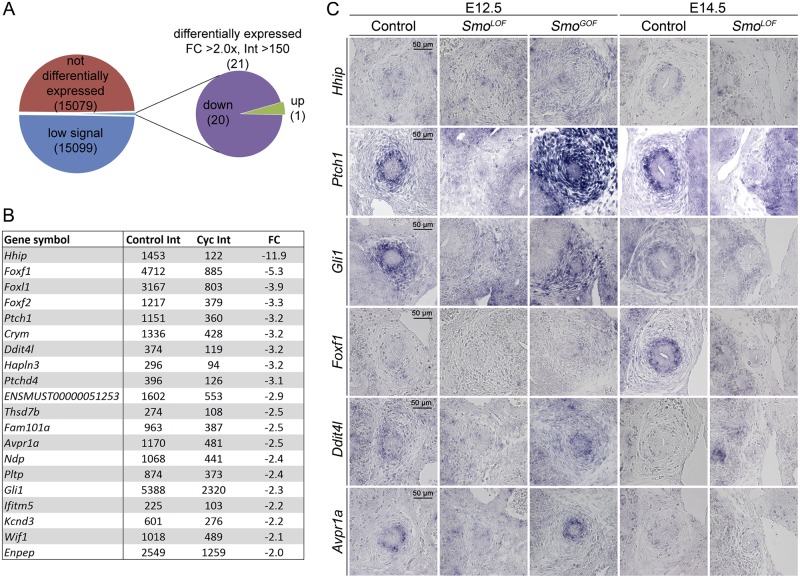
Microarray analysis detects transcriptional changes after loss of HH signaling in the ureteric mesenchyme.(A) Pie-chart summarizing the results from the microarray analysis of E12.5 ureters explanted and treated with DMSO or 10 μM cyclopamine for 18 h filtered with an intensity (Int) threshold of 150 and a fold change (FC) cut-off of 2.0. (B) Table of the downregulated transcripts. Shown are average intensities of transcripts in control and cyclopamine treated ureters and average fold changes (FC) of RNA intensities between the pools in two independent experiments. (C) In situ hybridization analysis of expression of microarray candidates on proximal ureter sections of control, Tbx18cre/+;Smofl/fl (SmoLOF) and Tbx18cre/+;R26mTmG/SmoM2 (SmoGOF) ureters at E12.5 and E14.5.